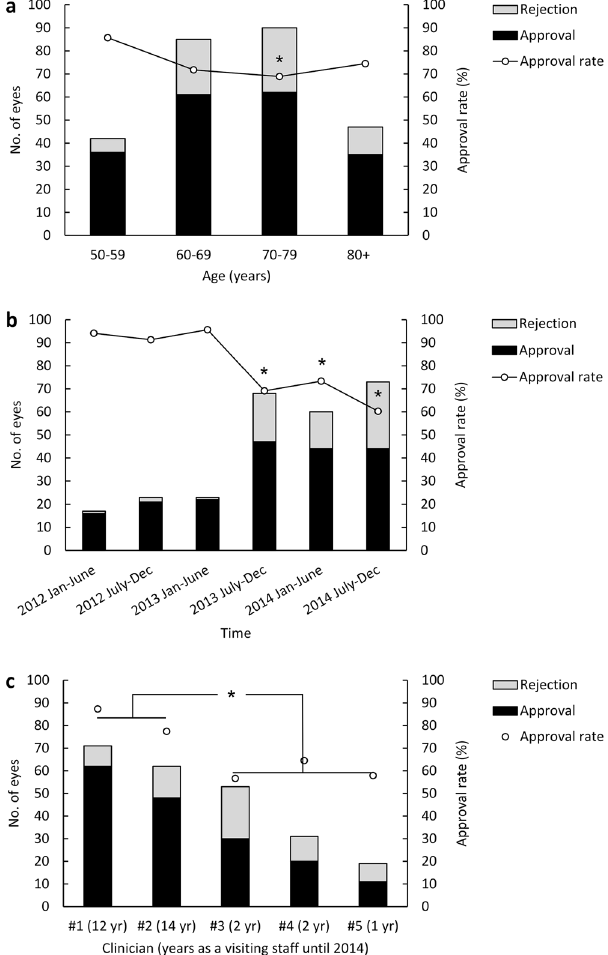
Figure 2. Distribution of 264 eyes (229 patients) with neovascular age-related macular degeneration treated at a university medical centre in 2012–2014 for which an application was made to the national health insurance system for funding of treatment with ranibizumab. ( a ) Distribution by age. * P < 0.05 versus 50–59 years. ( b ) Distribution by year and month at application. * P < 0.05 versus January to June 2012. ( c ) Distribution by clinician according to years of experience in ophthalmological practice. * P < 0.05; senior clinicians #1 and #2 versus junior clinicians #3, #4, and